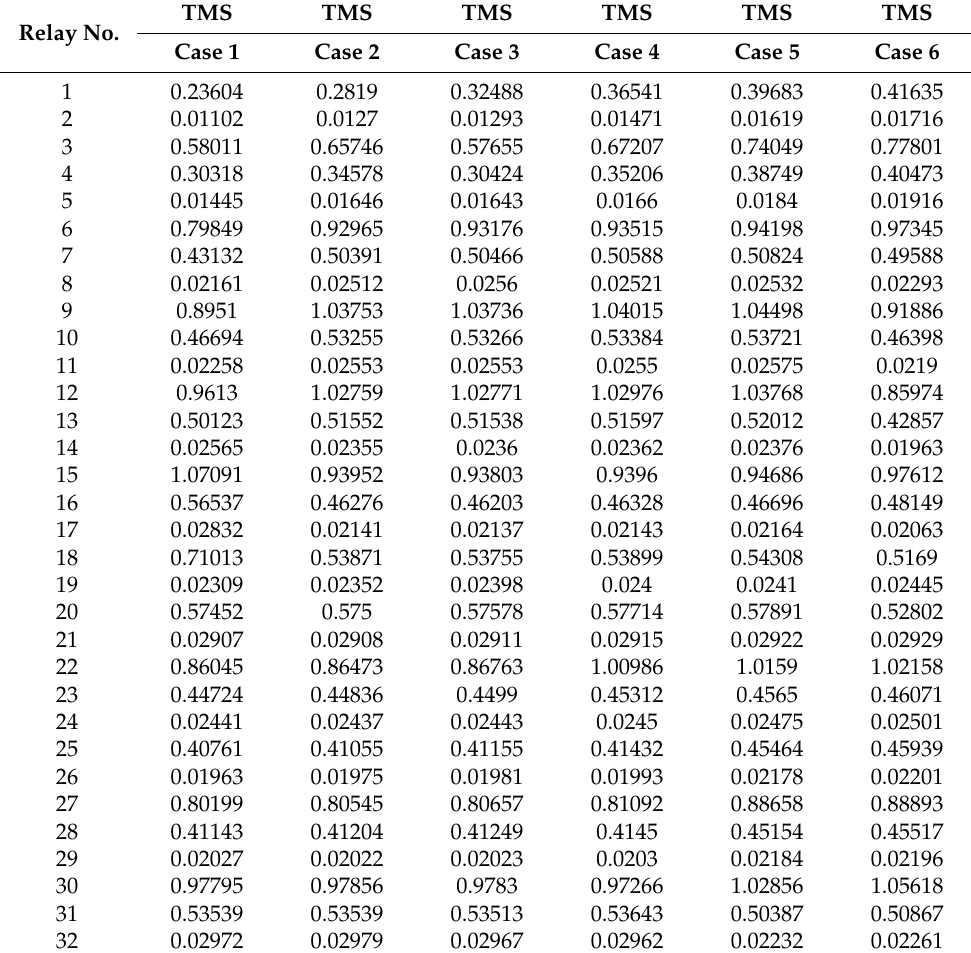
Table 3. Relay TMS parameter optimization using the GWO algorithm for different cases. Relay No.